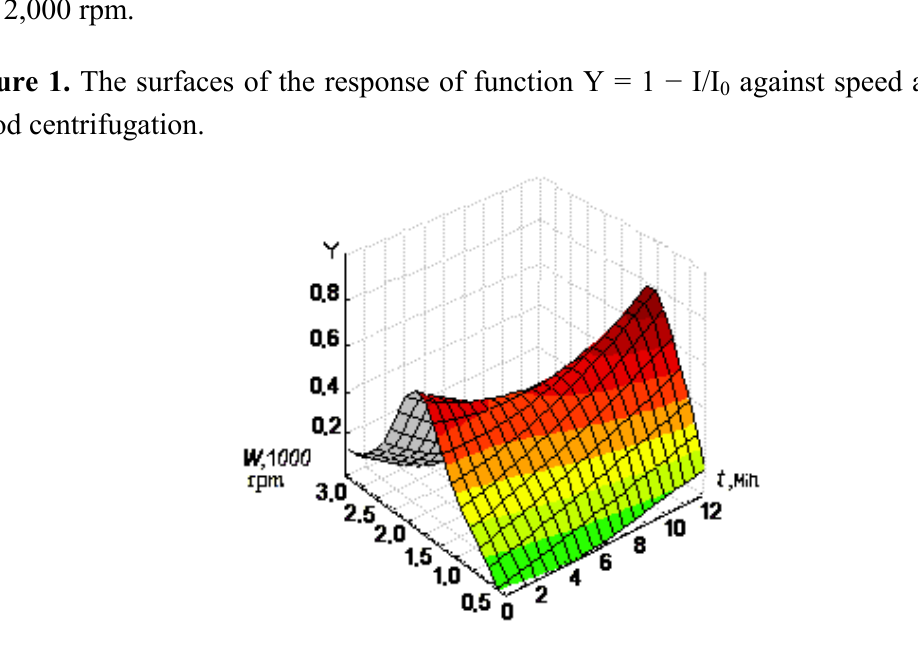
against speed and time of 0